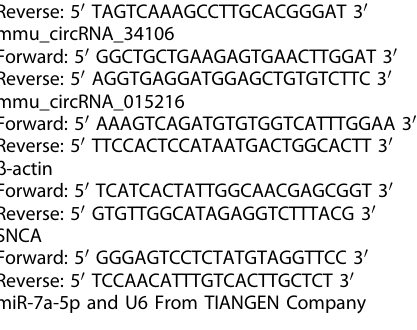
Fig. 7 Schematic diagram, circ-Pank1 acts as a competitive endogenous RNA (ceRNA) and regulates the expression of α -syn by adsorbing miR-7a-5p to affect the damage of dopaminergic neurons.